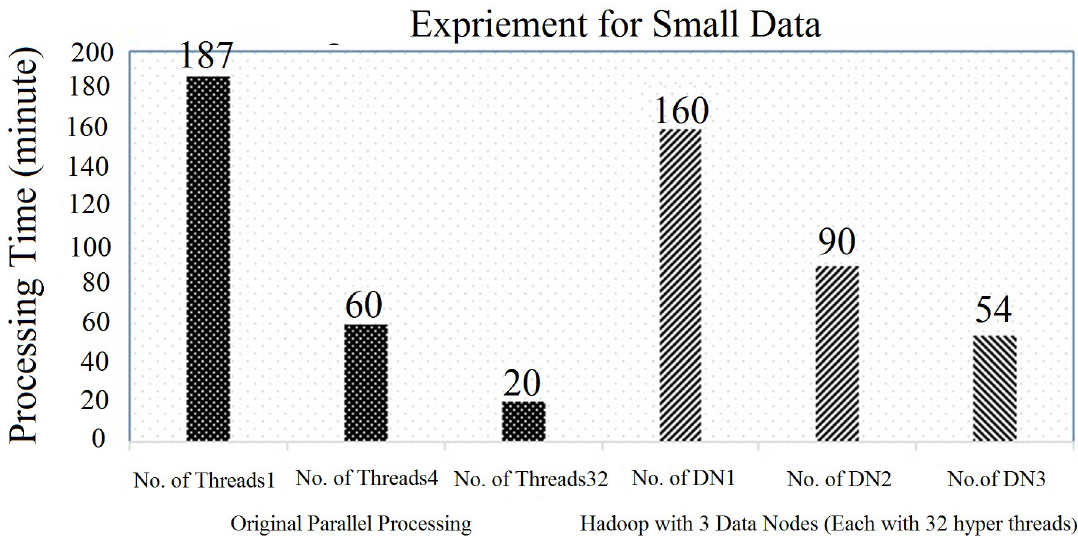
Fig 8. Comparison of original parallel processing with Hadoop (3 data node) with 32 hyper threads.